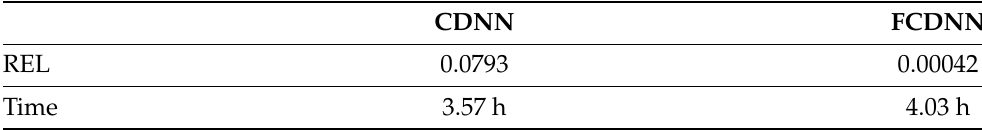
Table 4. REL and running time of the CDNN and FCDNN for Example